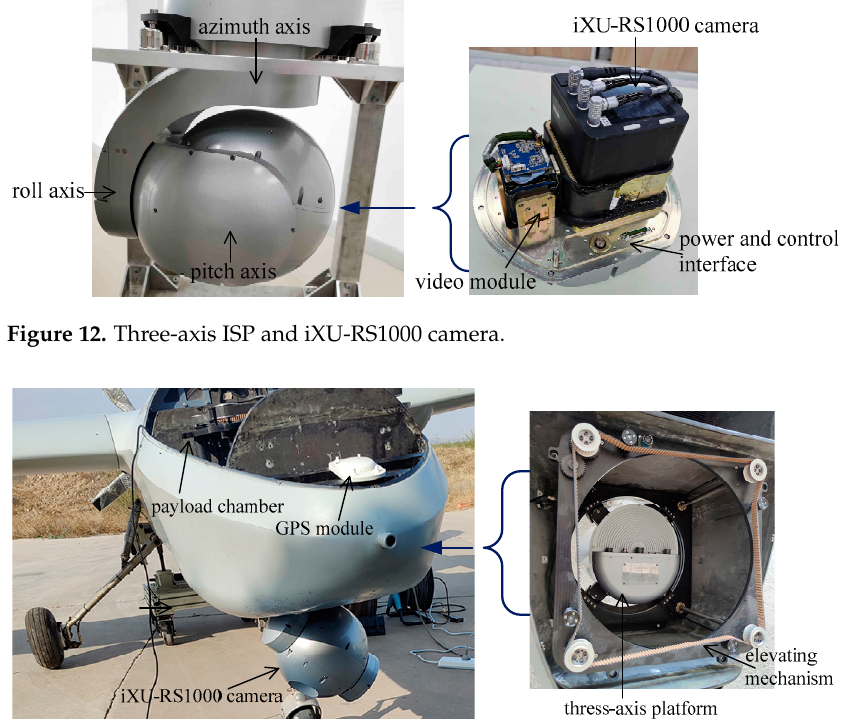
Figure 13. Three-axis ISP loaded in the payload chamber of an unmanned aircraft.